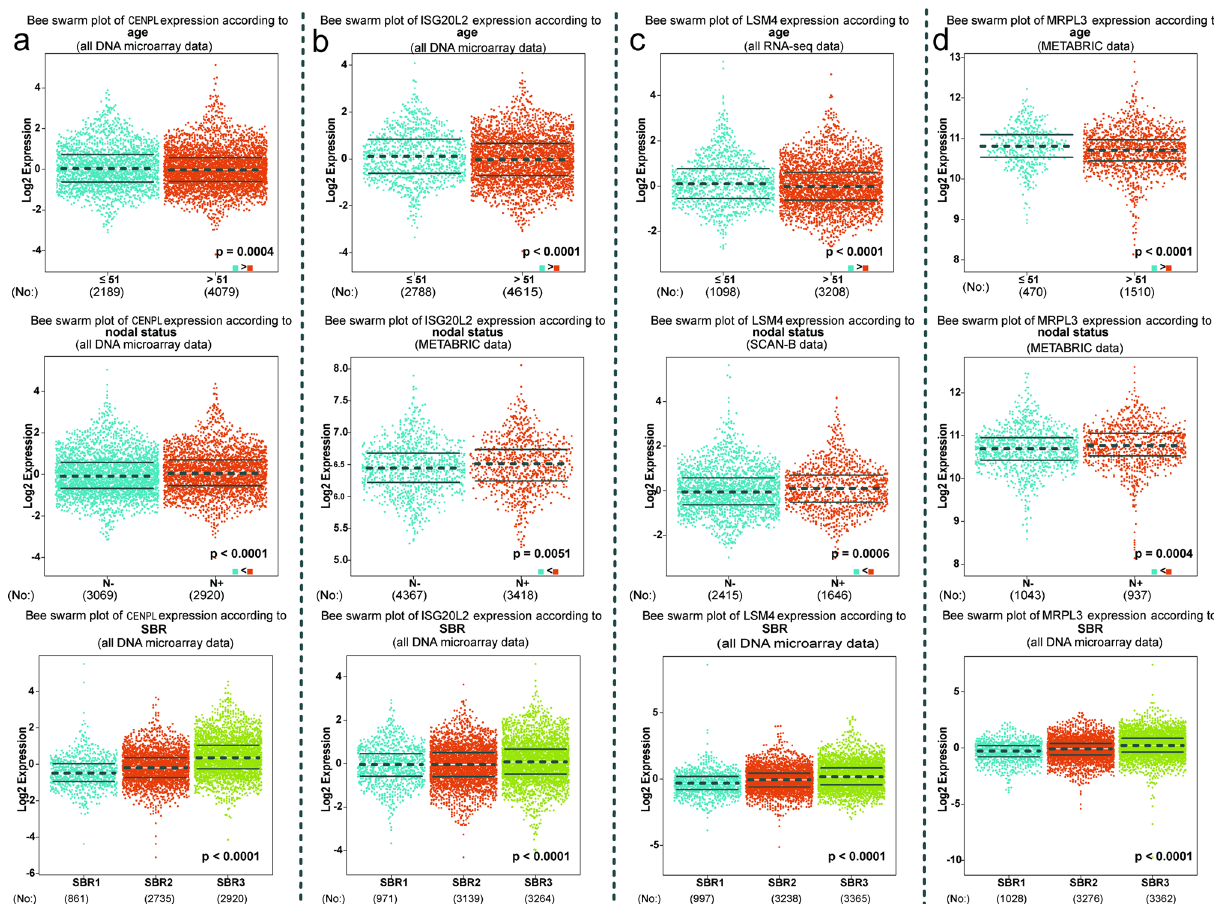
Figure 3. Relationship between four novel key genes expression levels and clinicopathological variables in breast cancer based on bc-GenExMiner